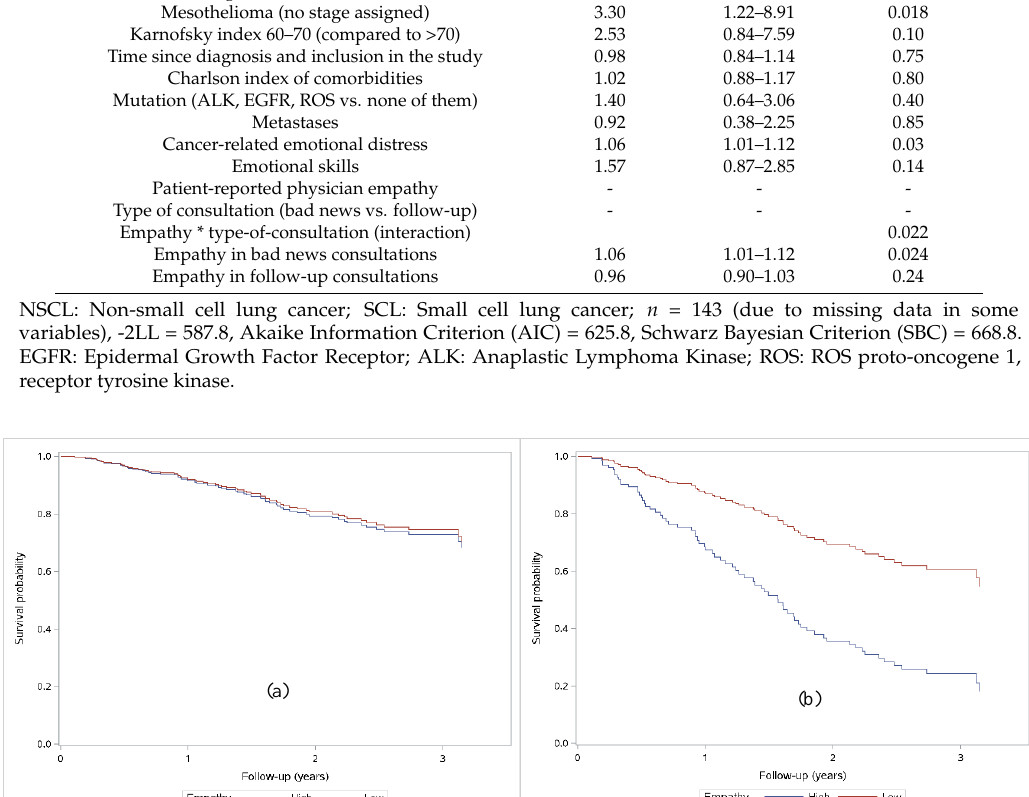
Figure 1. Survival probability for patients with high perceived empathy (>45) versus low empathy (≤ 45) by median split. ( a ) Follow-up consultations: adjusted Cox regressions showed no differences by empathy ( p = 0.24); ( b ) Bad-news consultations: adjusted Cox regressions showed differences by empathy ( p = 0.024).